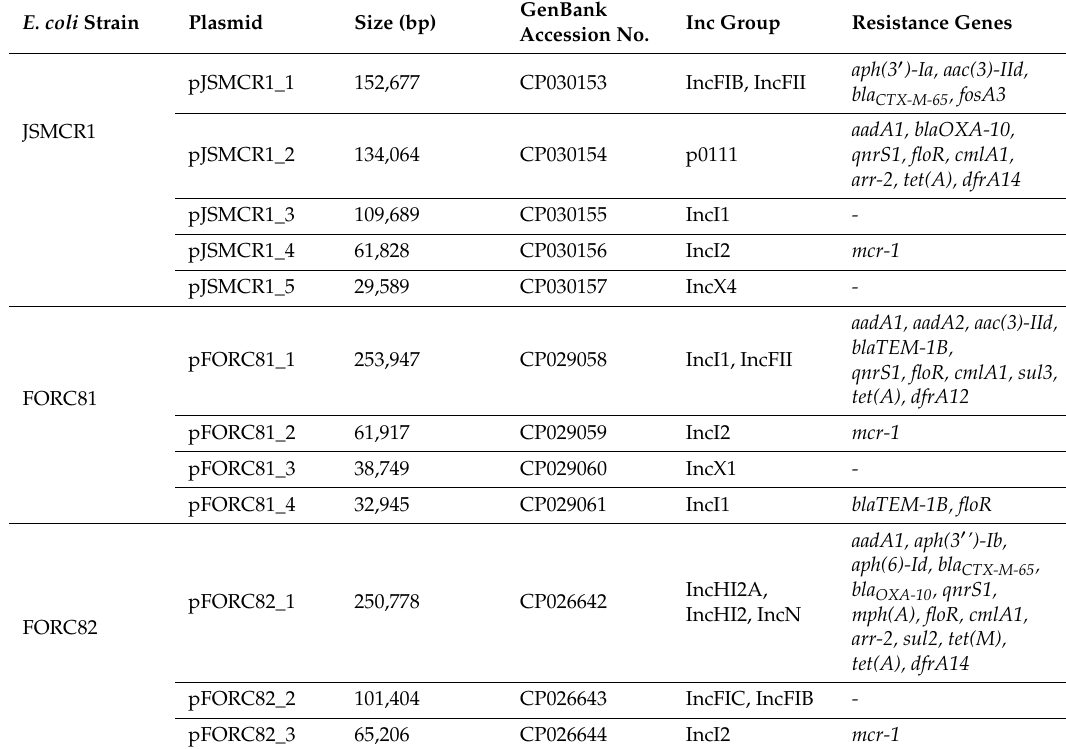
Table 1. Plasmids present in E. coli isolates harboring